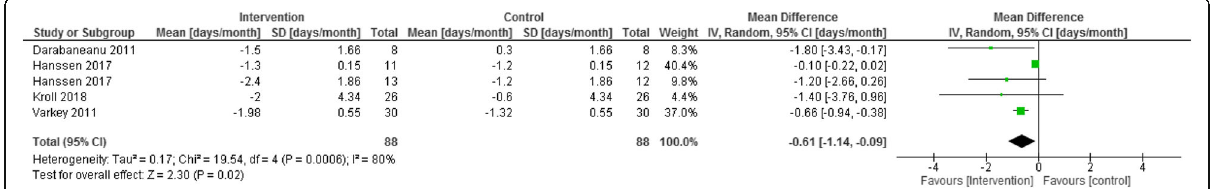
Fig. 4 Pooled data comparing intervention and control group on the number of migraine days